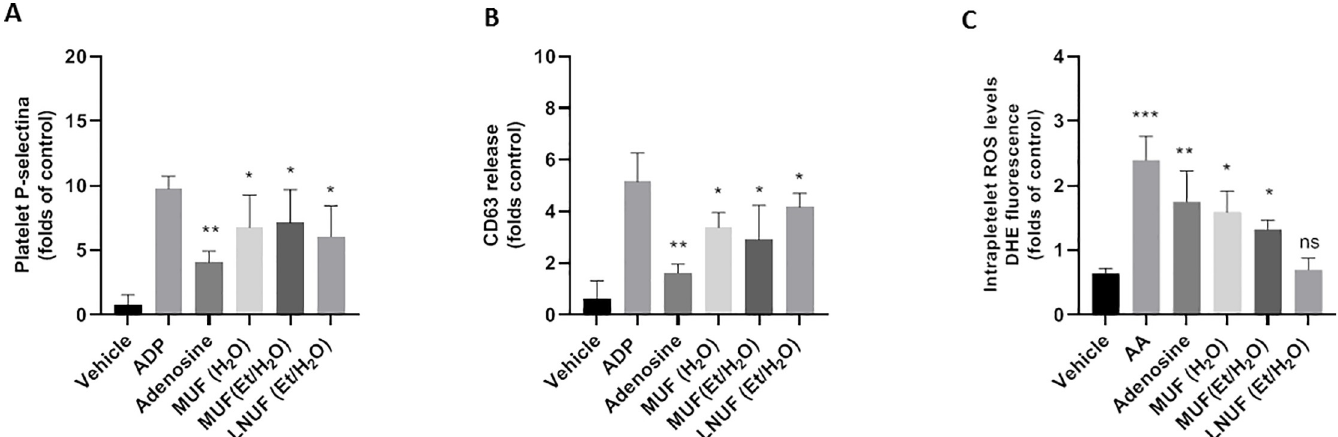
Fig 2. Effect of maqui extracts on platelet-granule release and ROS production. The data shown correspond to the expression of P-selectin (A) and CD63 (B), and ROS production (C). Data are expressed as mean ± SEM, n = 3, from at least three independent experiments. � p < 0.05, �� p < 0.01 and ��� p < 0.001 vs. ADP (A and B) and antimycin A (C). MUF (H 2 O): Aqueous extract of Morena unripe fruit; MUF (EtOH/H 2 O): Ethanolic extract of Morena unripe fruit; LNUF (EtOH/H 2 O): Ethanolic extract of Luna Nueva unripe fruit.